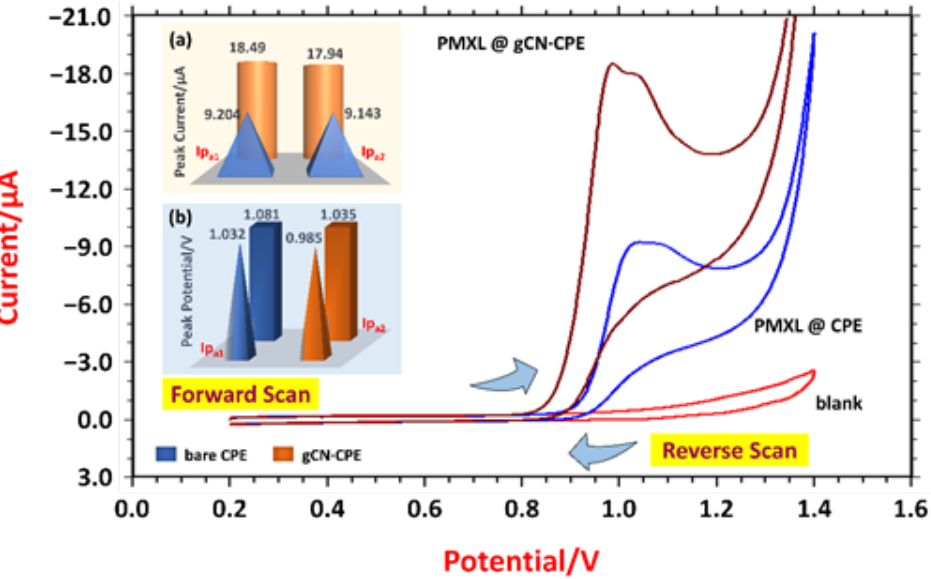
Figure 4. Voltammetric response of 0.5 mM PMXL in PBS of pH 3.02. Comparative bar chart of ( a ) anodic oxidative currents and ( b ) detection